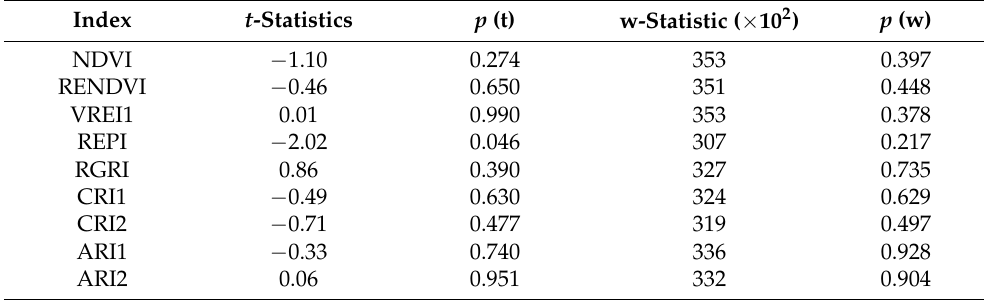
Table 5. Result of comparison of vegetation index values between rot-infected and rot-free trees using Student’s t -test and Wilcoxon’s rank sum test for Nordskogen imagery.